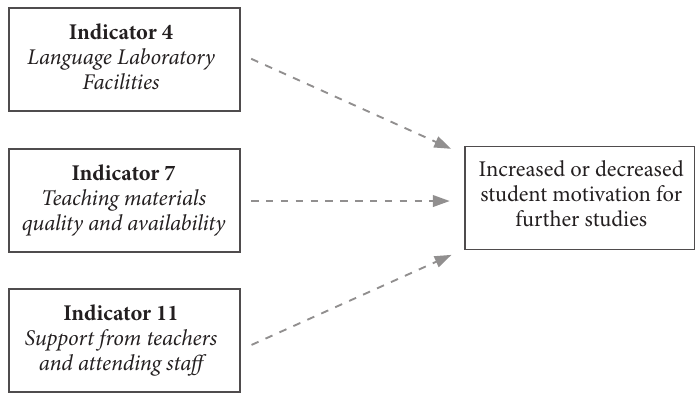
Fig. 2. Impact of some factors associated with the educational environment quality on